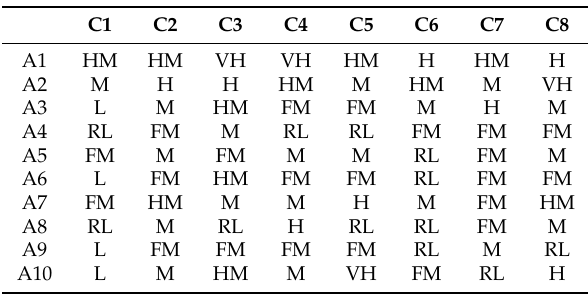
Table 8. The initial evaluation results consider the criteria for each quality